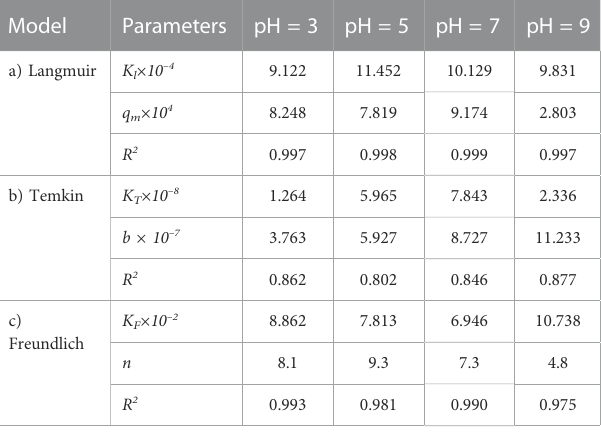
TABLE 8 Parameters of a) Langmuir, b) Temkin, and c) Freundlich isotherm models at different pH values using Oil sludge 1 as carbon active at T = 318 K and adsorbent concentration of 100 mg/L.